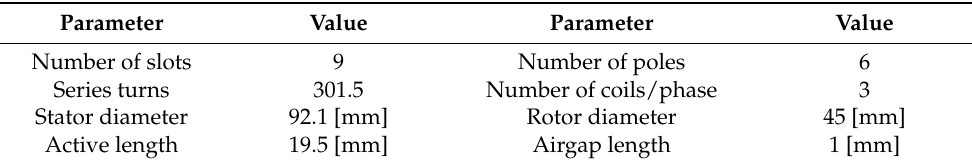
Figure 8. ( a ) Tested IPM machine; ( b ) B − H characteristics of the tested NdFeB magnets at 20 degC and 100 degC. Table 3. Key parameters for the tested IPM machine.